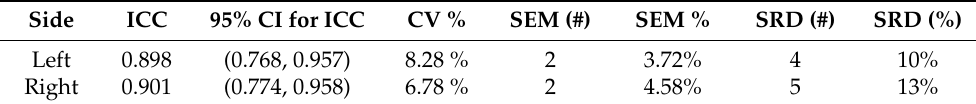
Table 1. Reproducibility parameters of single leg hamstring bridge (SLHB) test in soldiers (N = 20).